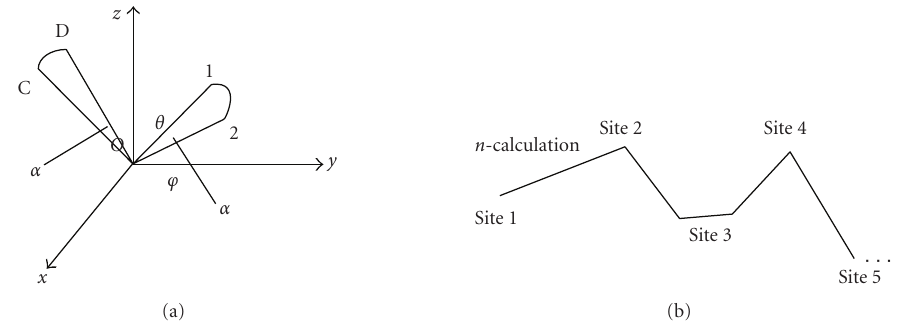
Figure 1: The mapping principle of TBRS is shown in (a). The process of obtaining new sites through n -calculation is described in (b).